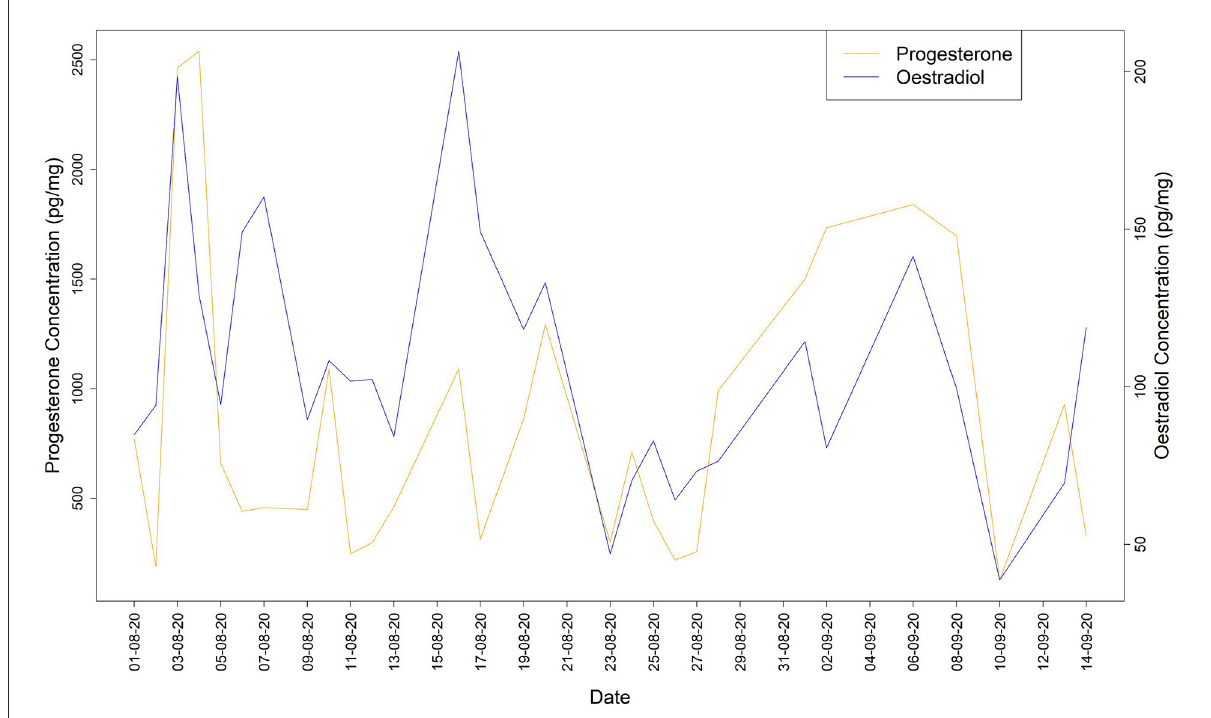
FIGURE1 Oestradiol and progesterone concentrations during the non-breeding period.